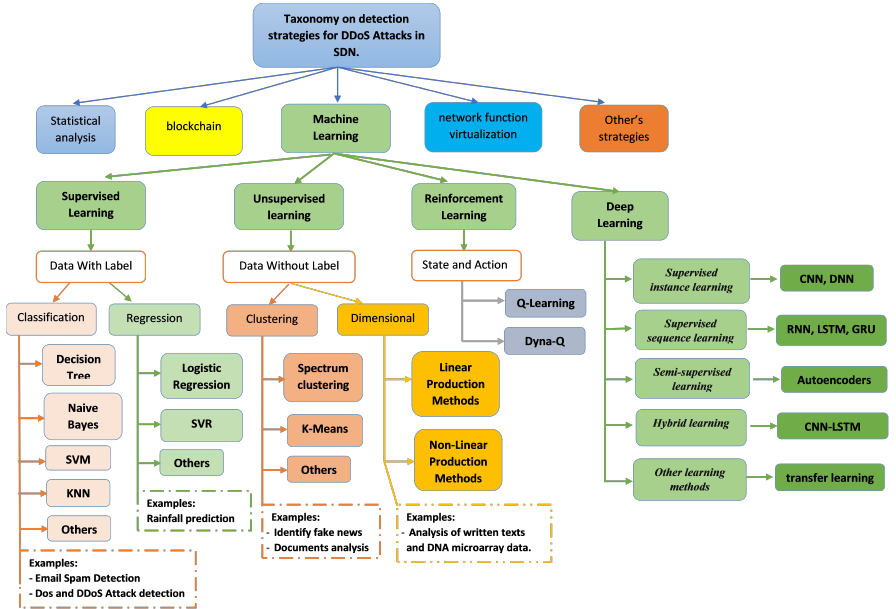
Figure 4. Taxonomy of machine learning-based and deep learning-based DDoS detection